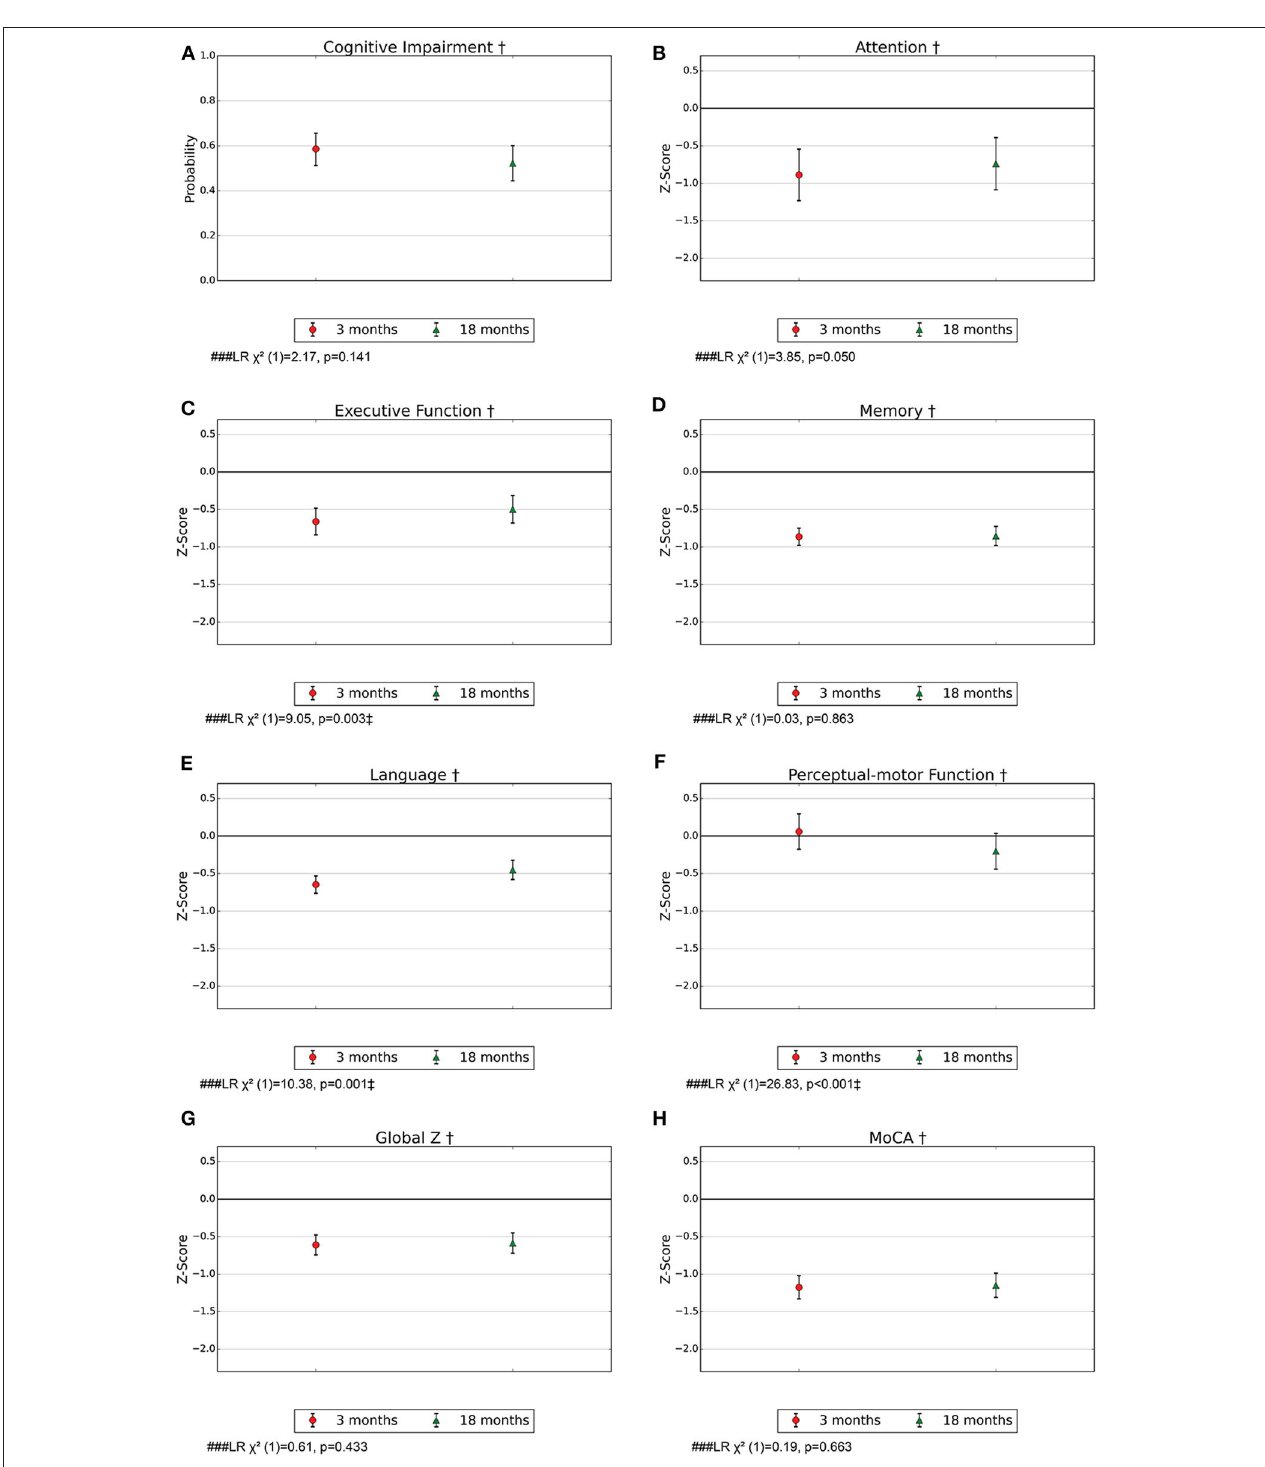
FIGURE 2 | (A–H) Probability for cognitive impairment according to DSM-5 criteria with 95% CI and mean z-score with 95% CI for the cognitive domains at 3 and 18 months post-stroke in model 1. MoCA, Montreal Cognitive Assessment. † Adjusted for age, education, and sex. ### LR χ 2 (1), Likelihood Ratio test model 1 vs a model with only age, education, and sex as confounders, with one degree of freedom; hypothesis test of whether there is an effect of time. ‡ p < 0.01.